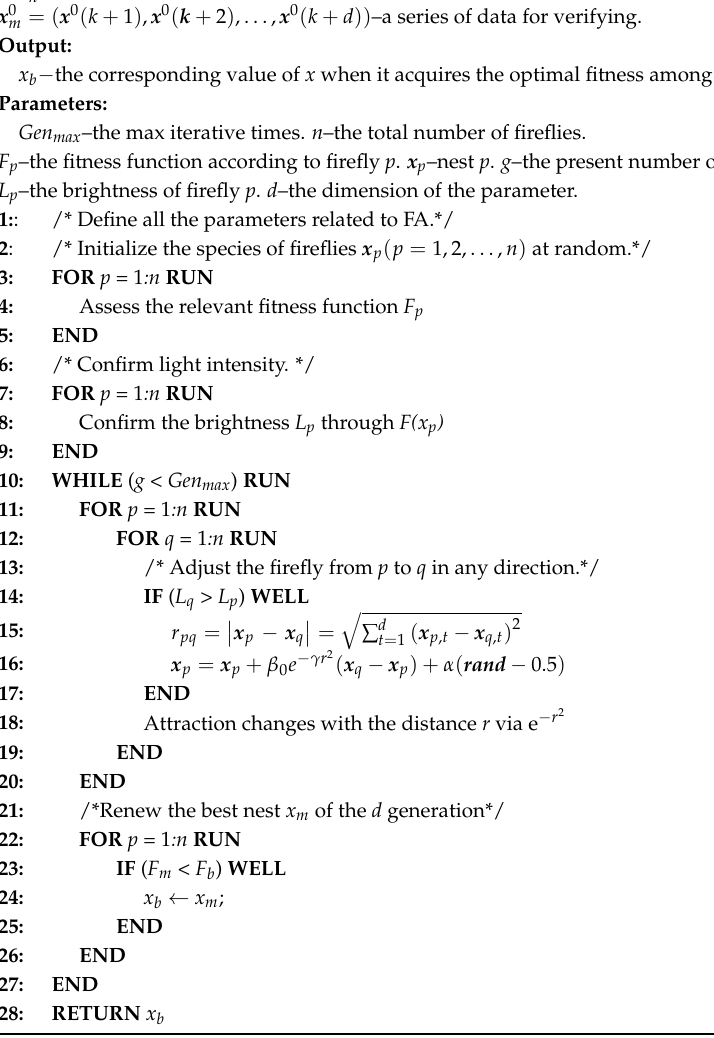
Algorithm A2. FA.